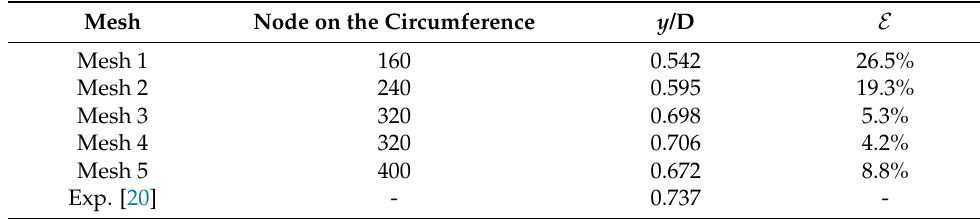
Table 2. Mesh independence